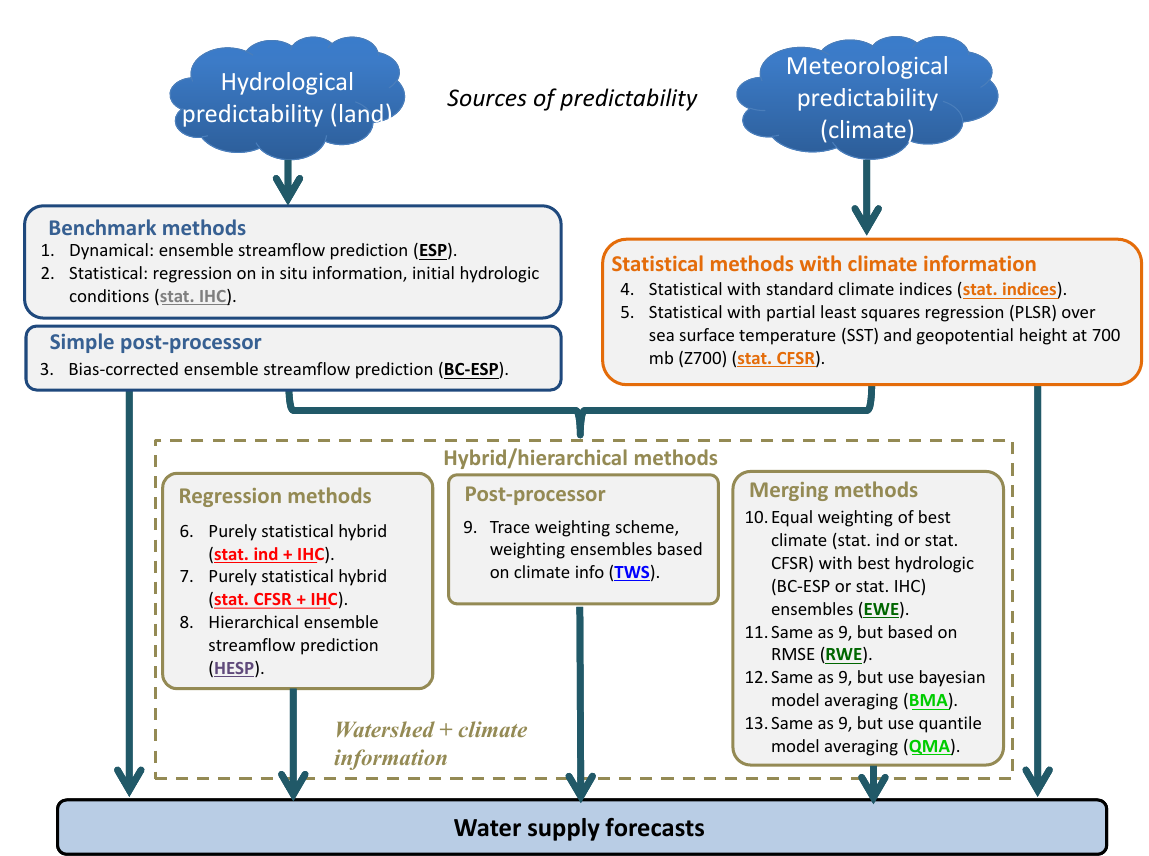
Figure 3. Schematic figure showing all seasonal streamflow forecasting methods included in the intercomparison framework. The benchmark methods are operationally implemented in the western United States, and they are solely based on hydrologic